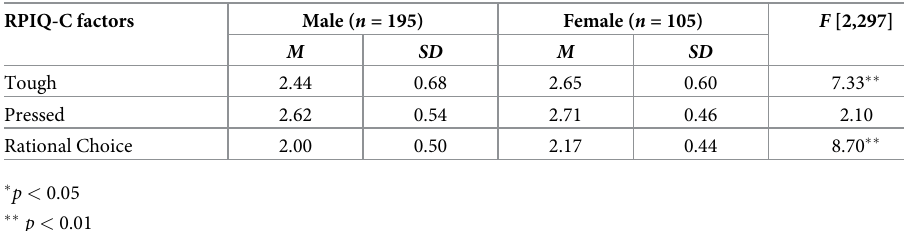
Table 4. Differences in the RPIQ-C factors by gender.